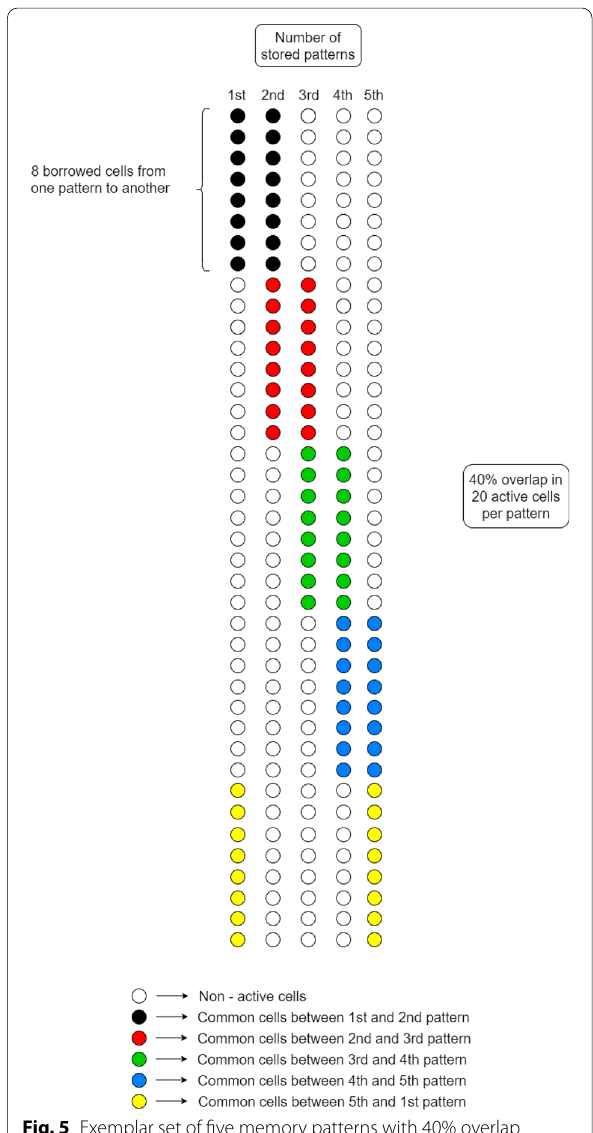
Fig. 5 Exemplar set of five memory patterns with 40% overlap between